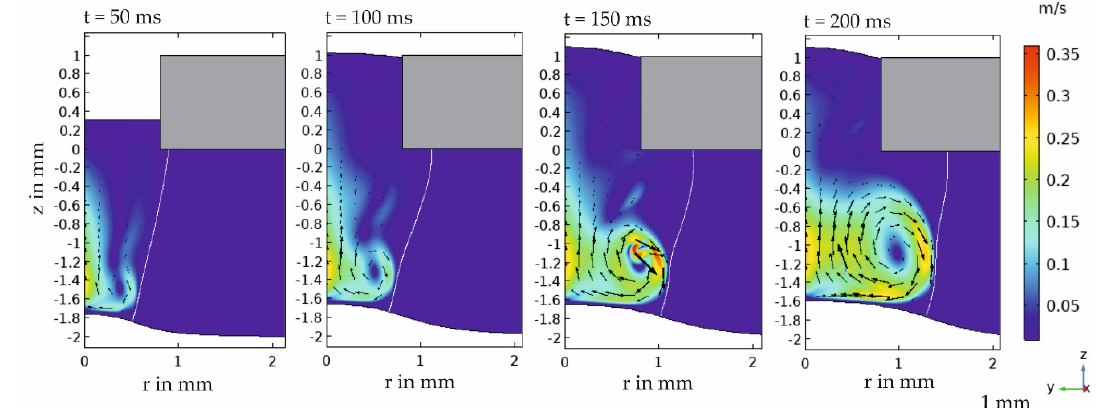
Figure 12. The numerical results of melt pool development at magnetic field powers from 0 to 1936 W and the melting isotherm (white solid line) in the symmetry plane at 100 ms ( a ) and 200 ms ( b ).